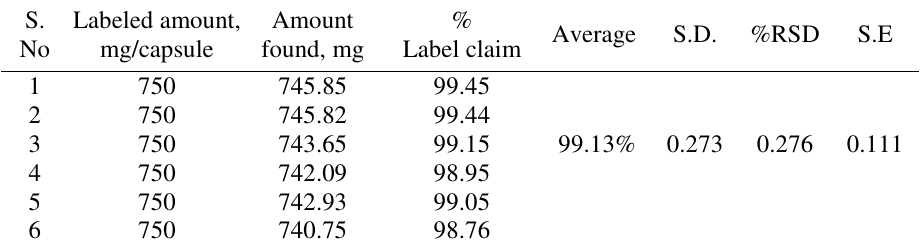
Table 2. Analysis of tablet formulation.